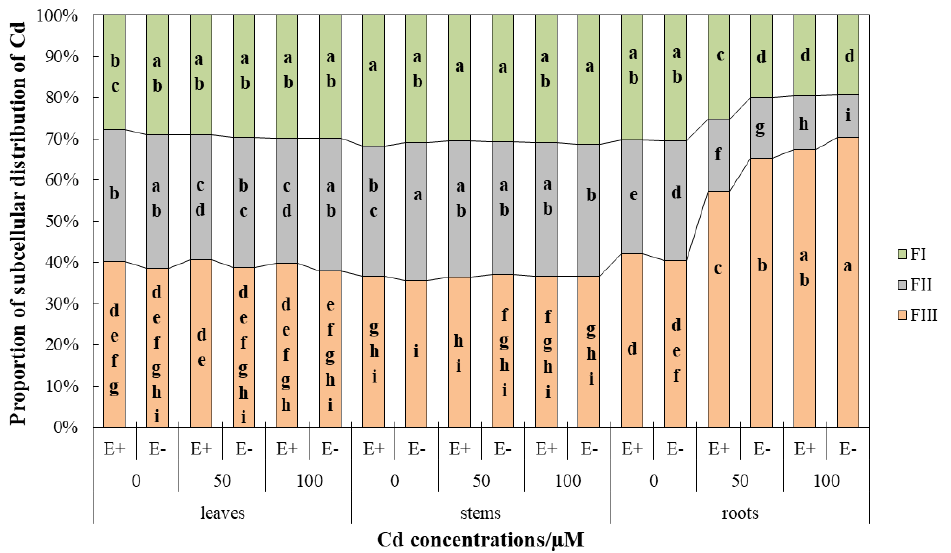
Figure 5. Subcellular proportions of Cd in the leaves, roots, and stems of Hordeum brevisublatum . FI: cell wall component, FII: organelle fraction, and FIII: soluble fraction. Lowercase letters (a–i) in the middle of bars indicate significant differences ( p < 0.05) of E+ and E − plants in different cell components under the different concentrations of CdCl 2 stress.